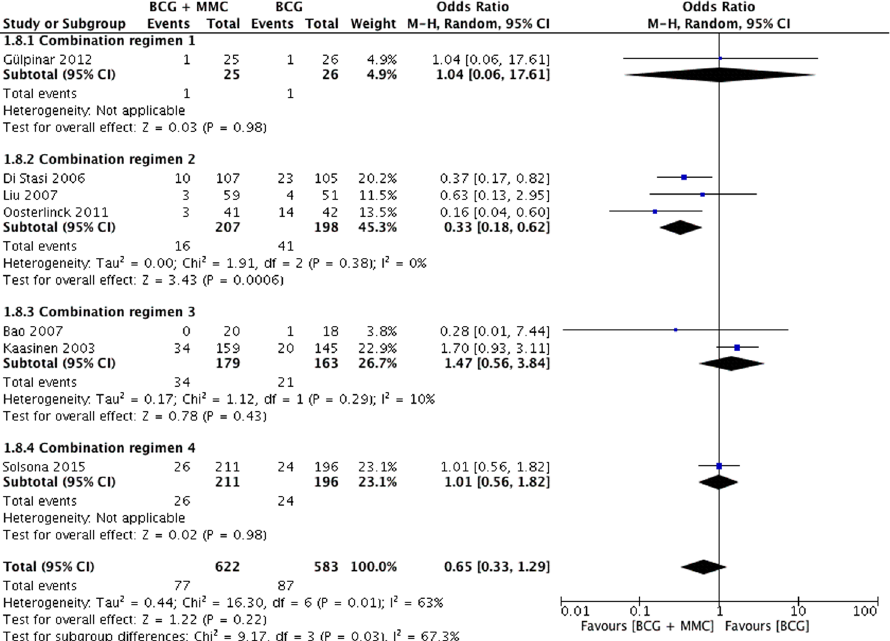
Figure 4. Forest plot of tumor progression rate comparing combination therapy with BCG monotherapy.